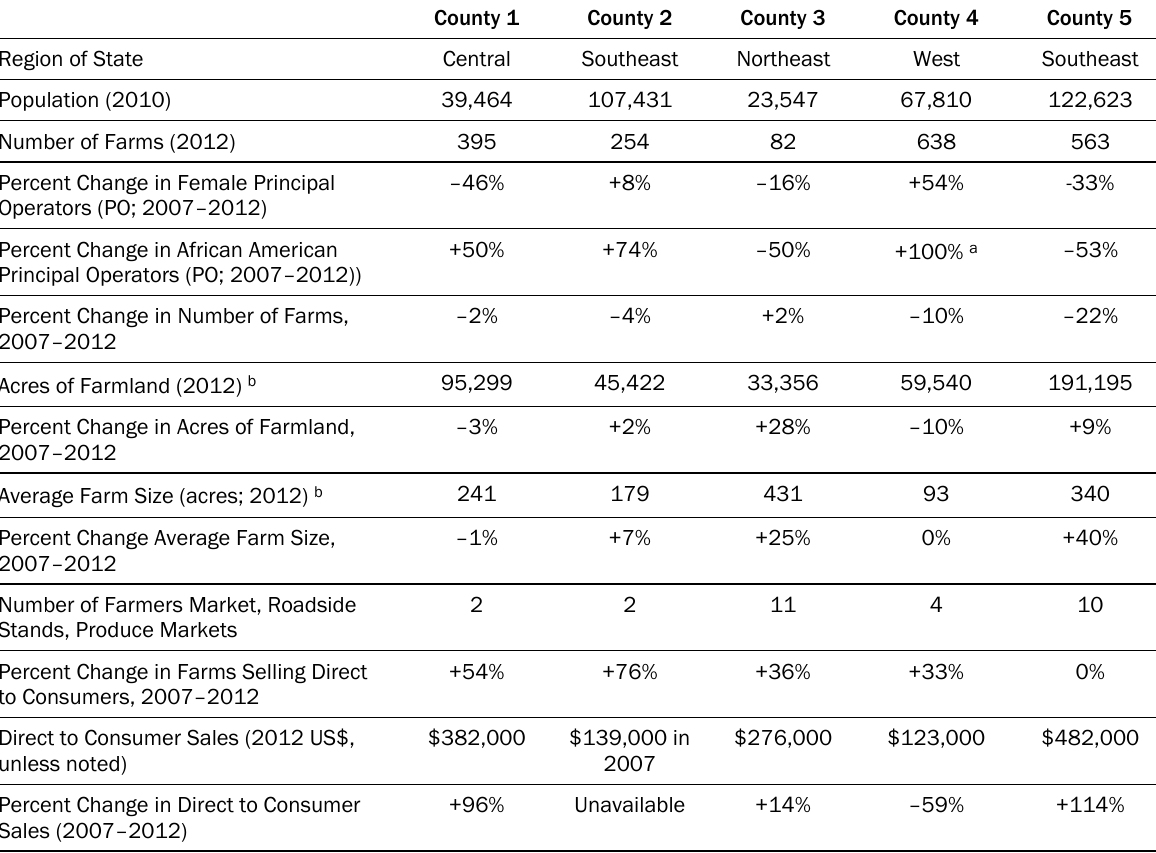
Table B1. Select Demographic and Agricultural Characteristics of Pilot